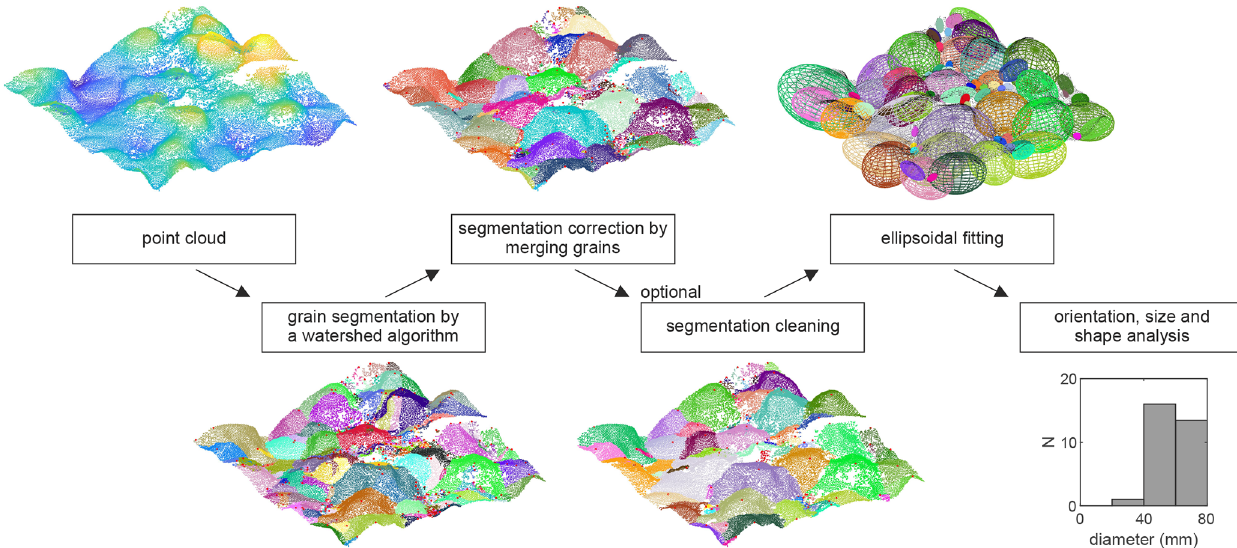
Figure 1. Overview of the G3Point algorithm showing the main series of functions (center) and the results (top and bottom figures). Each main function is described in detail in the Method